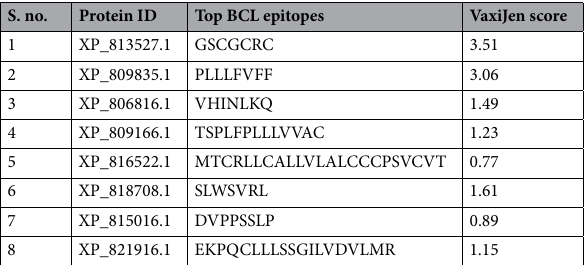
Table 4. Predicted linear B-cell epitopes in the selected proteins for designing vaccine constructs.